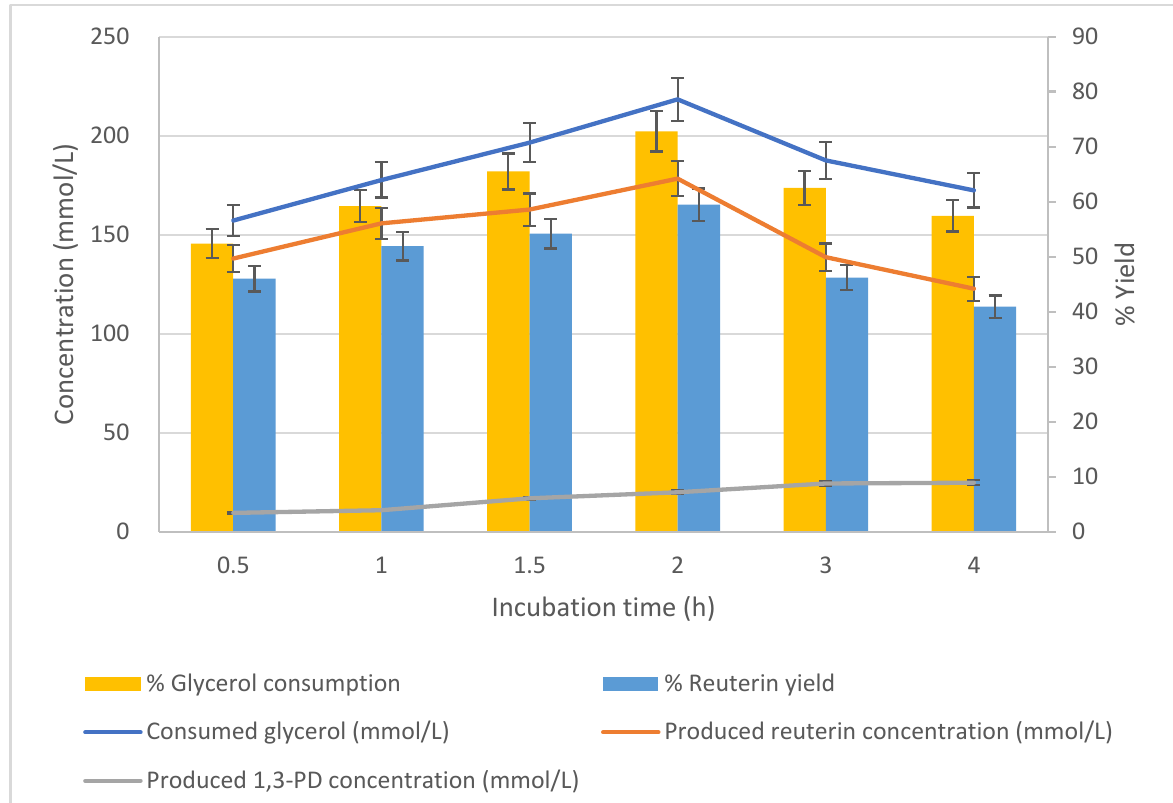
Figure 8. Effect of incubation time on reuterin production.